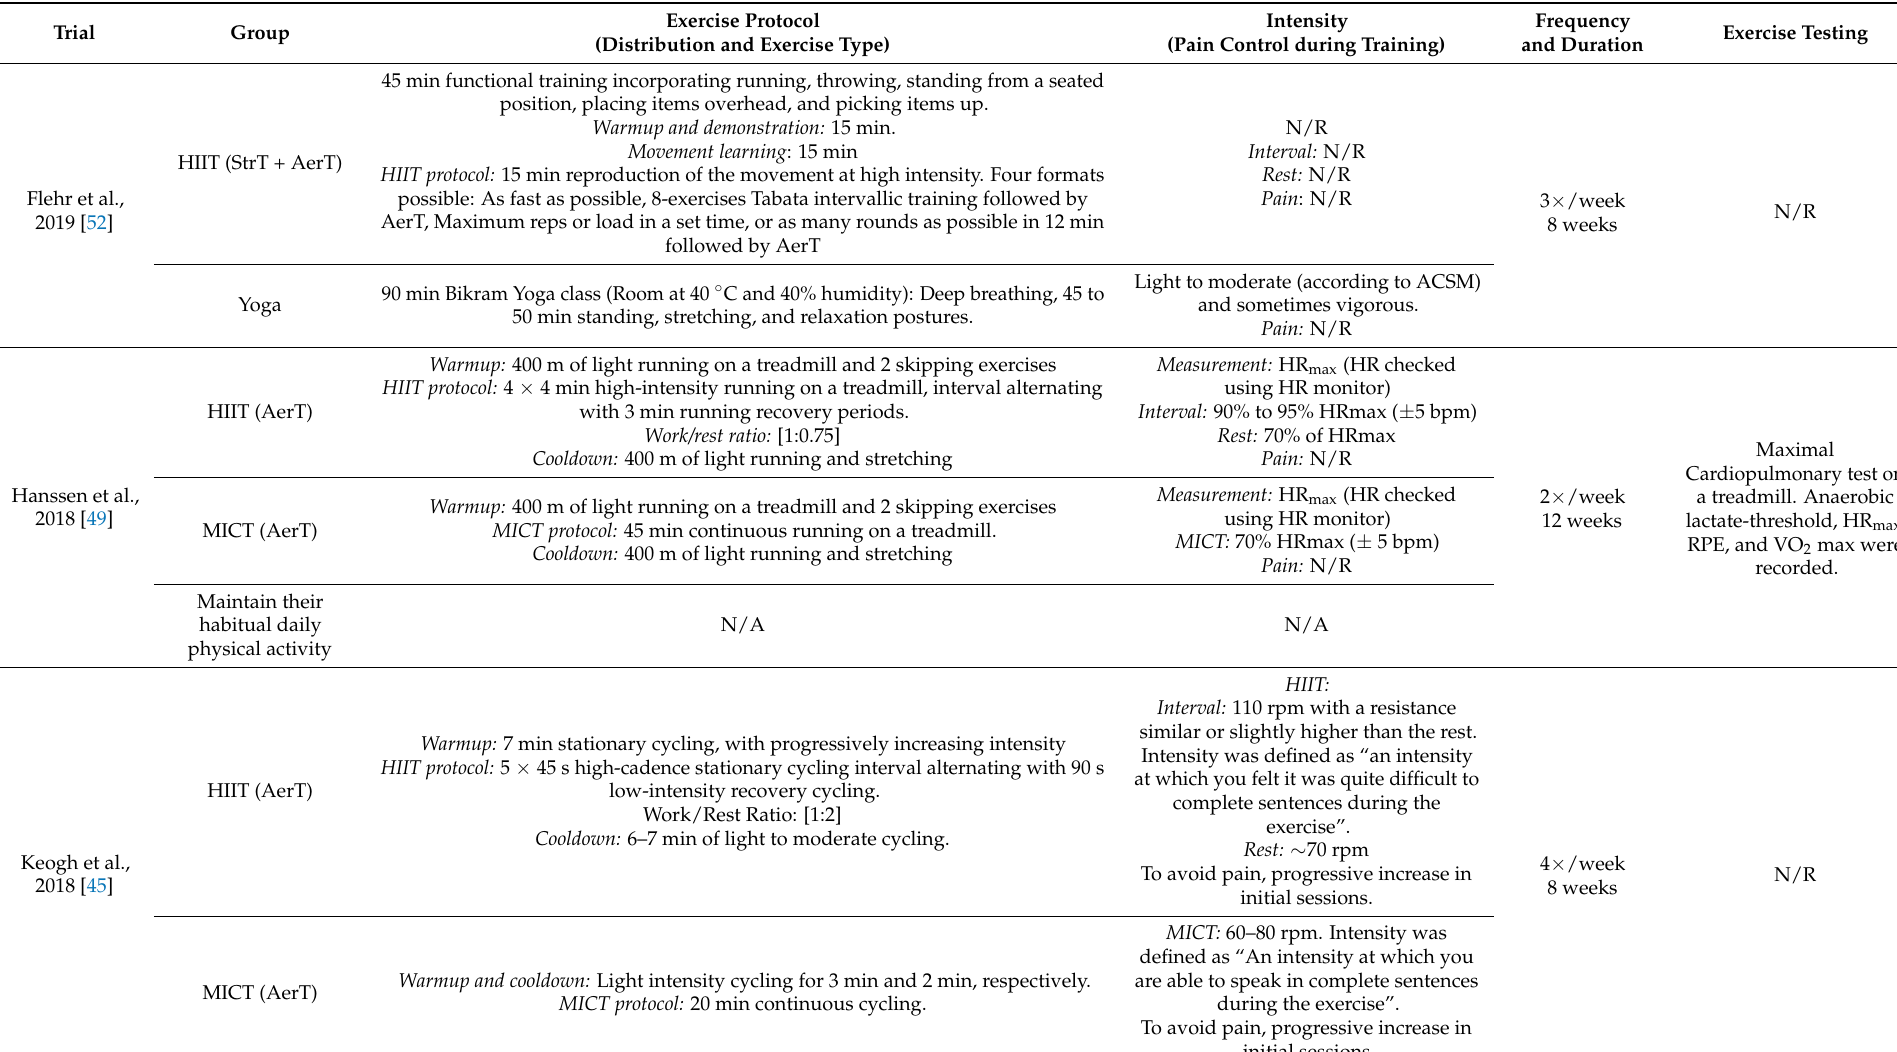
Exercise Protocol (Distribution and Exercise Type)